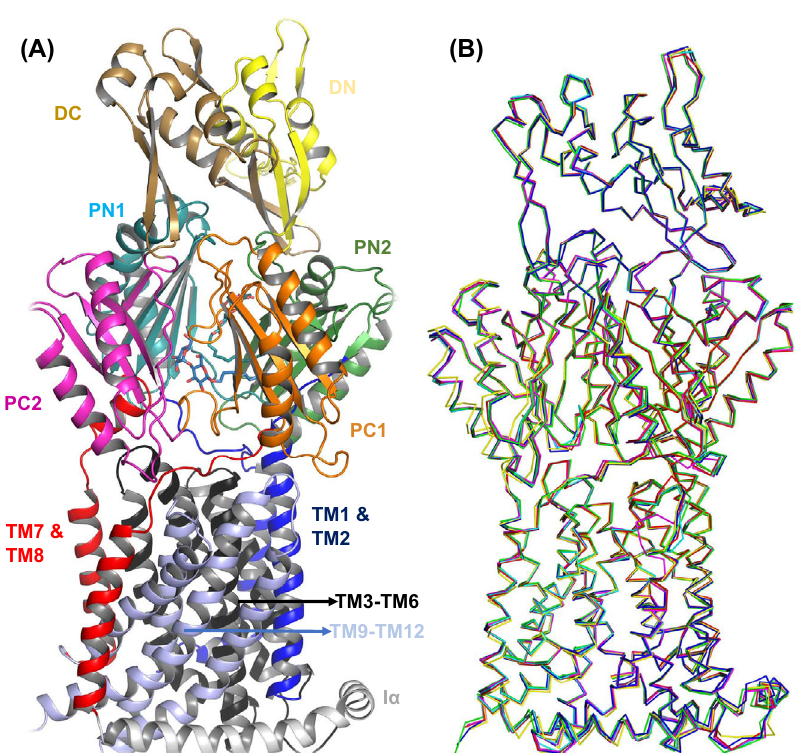
Fig. 1 OqxB structural features. The OqxB structure single protomer ( A ) with important sub-domains is highlighted with varied colors and labeled accordingly. The porter sub-domains PC1, PC2, PN1, and PN2 are highlighted with orange, magenta, cyan, and green color cartoon, respectively. The six OqxB protomers ( B ) superimposed to demonstrate the identical nature of individual